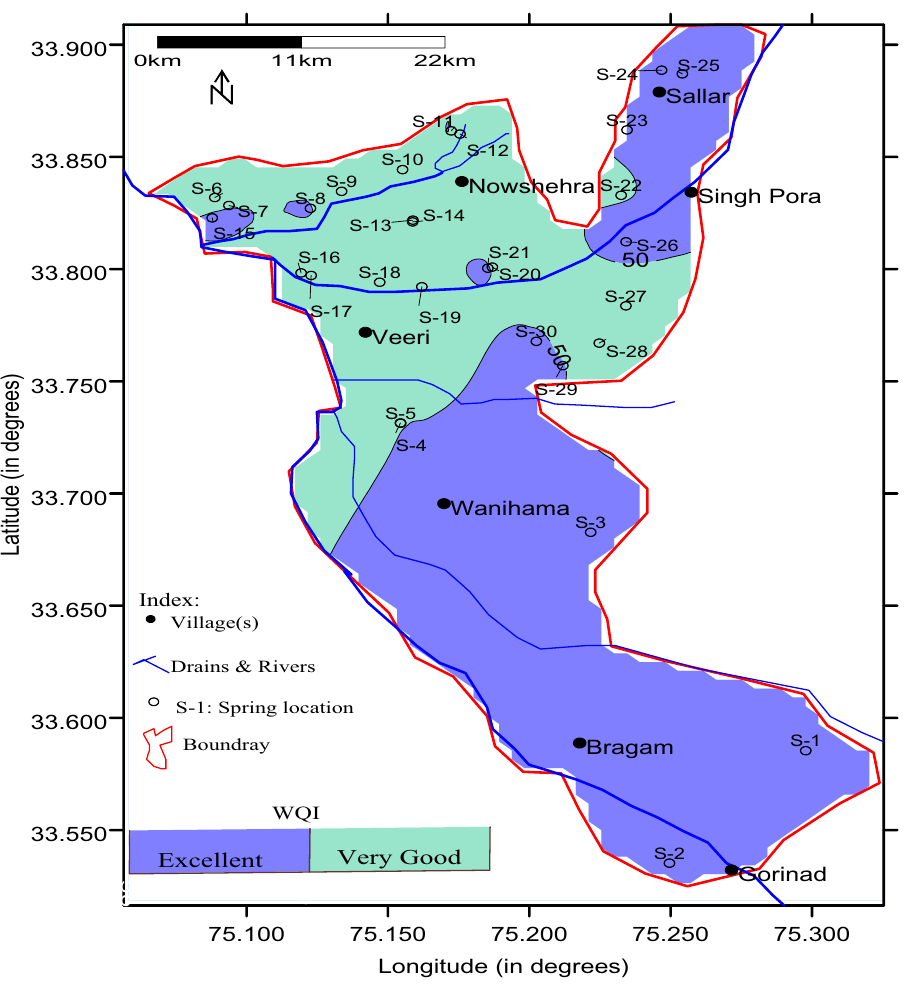
Fig. 8 Water quality map of the studied springs in a part of Anantnag district,